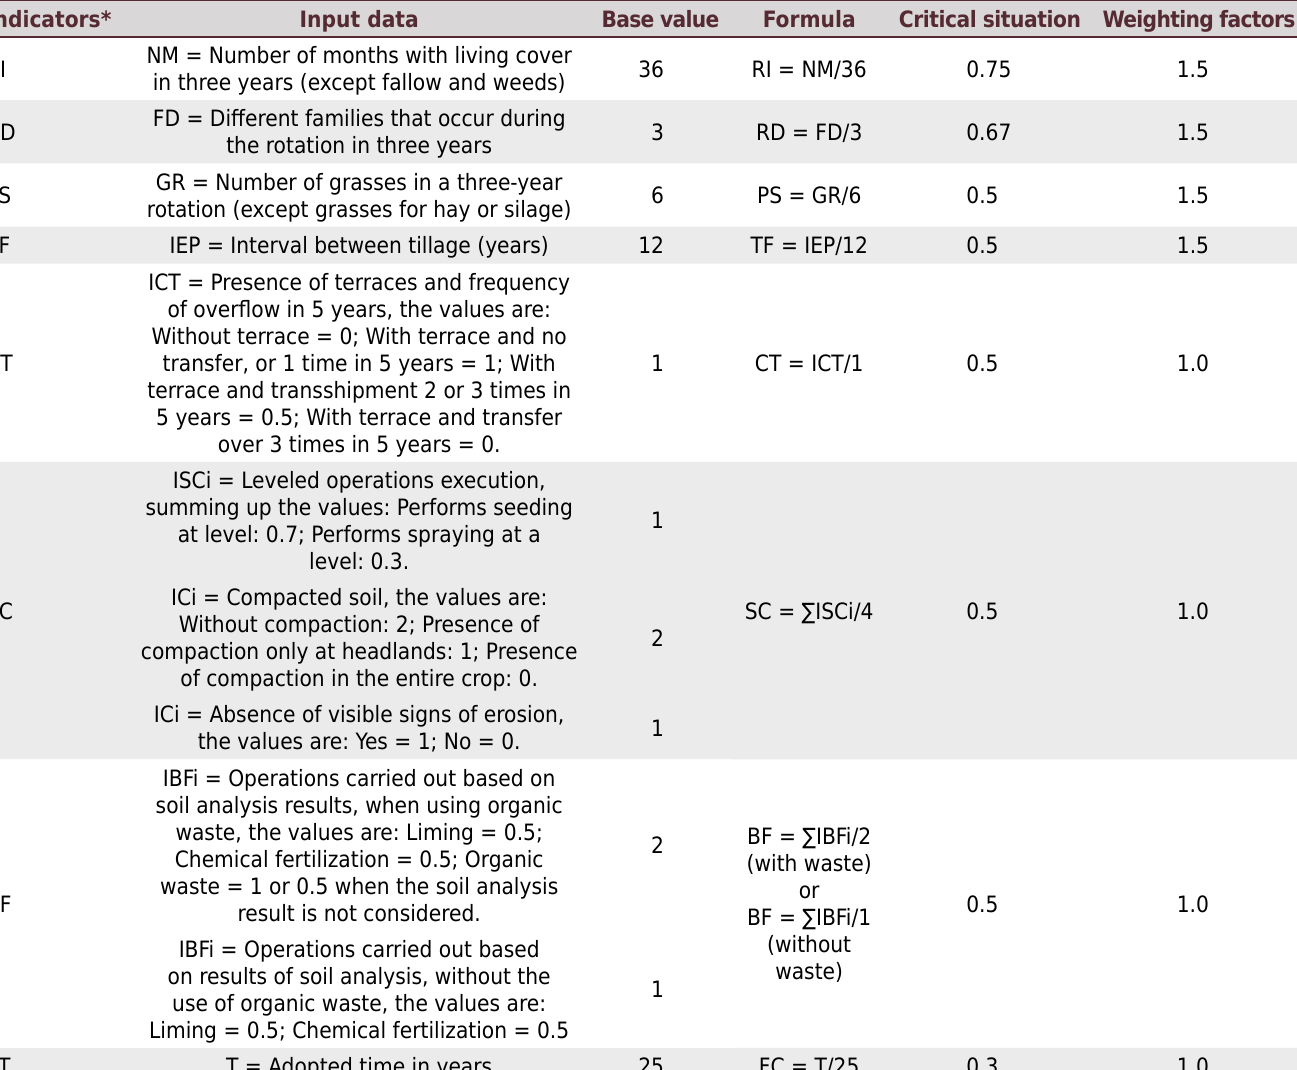
Table 2. Indicators, input data, base value, calculation formula, critical situation, and weighting factors as components of the no- tillage system participatory quality index Indicators* Input data Base value